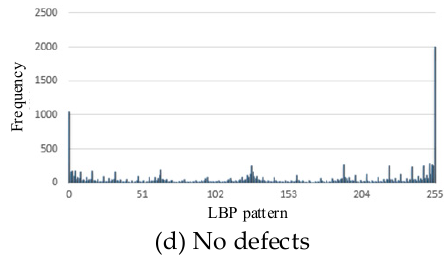
Figure 8. The 256-dimensionial histogram of LBP patterns: scratches ( a ), slags ( b ), peels ( c ), no defects ( d ). LBP uniform pattern described in Section 2 can be used for dimension reduction for the LBP patterns. We used the LBP uniform pattern and reduced the dimension of LBP patterns from 256 to 59.